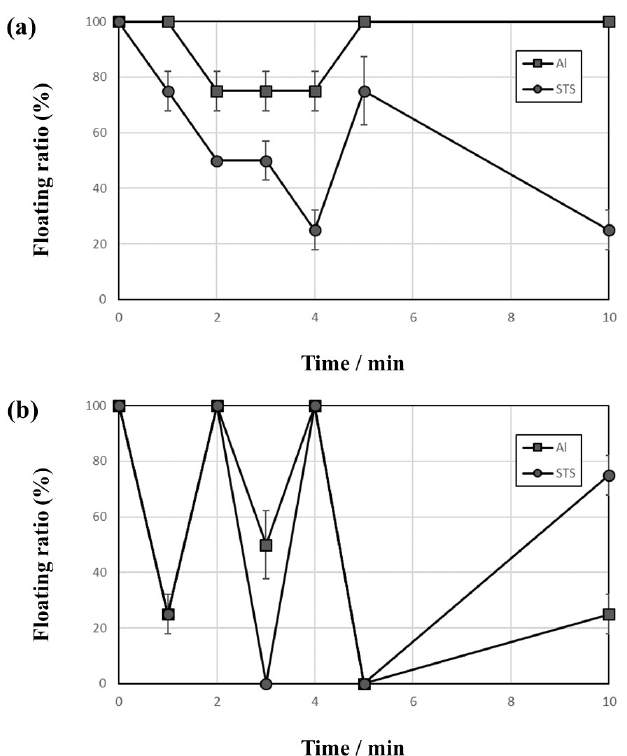
Figure 4. Floating ratio change with time of Al and STS scraps during vibrating test with vibration amplitudes of ( a ) 2.5 and ( b ) 3 mm using 2-mm zirconia balls as the medium.